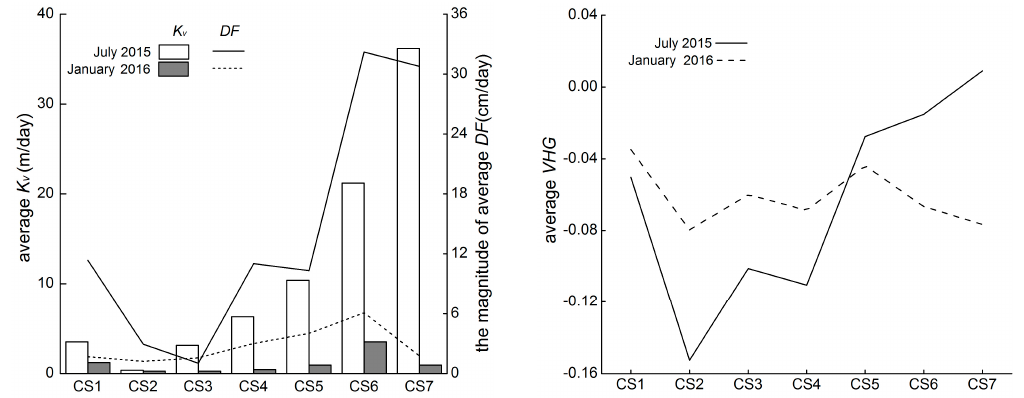
Figure 5. Variations of K v , VHG , and DF along the channel bend in July 2015 and January 2016.